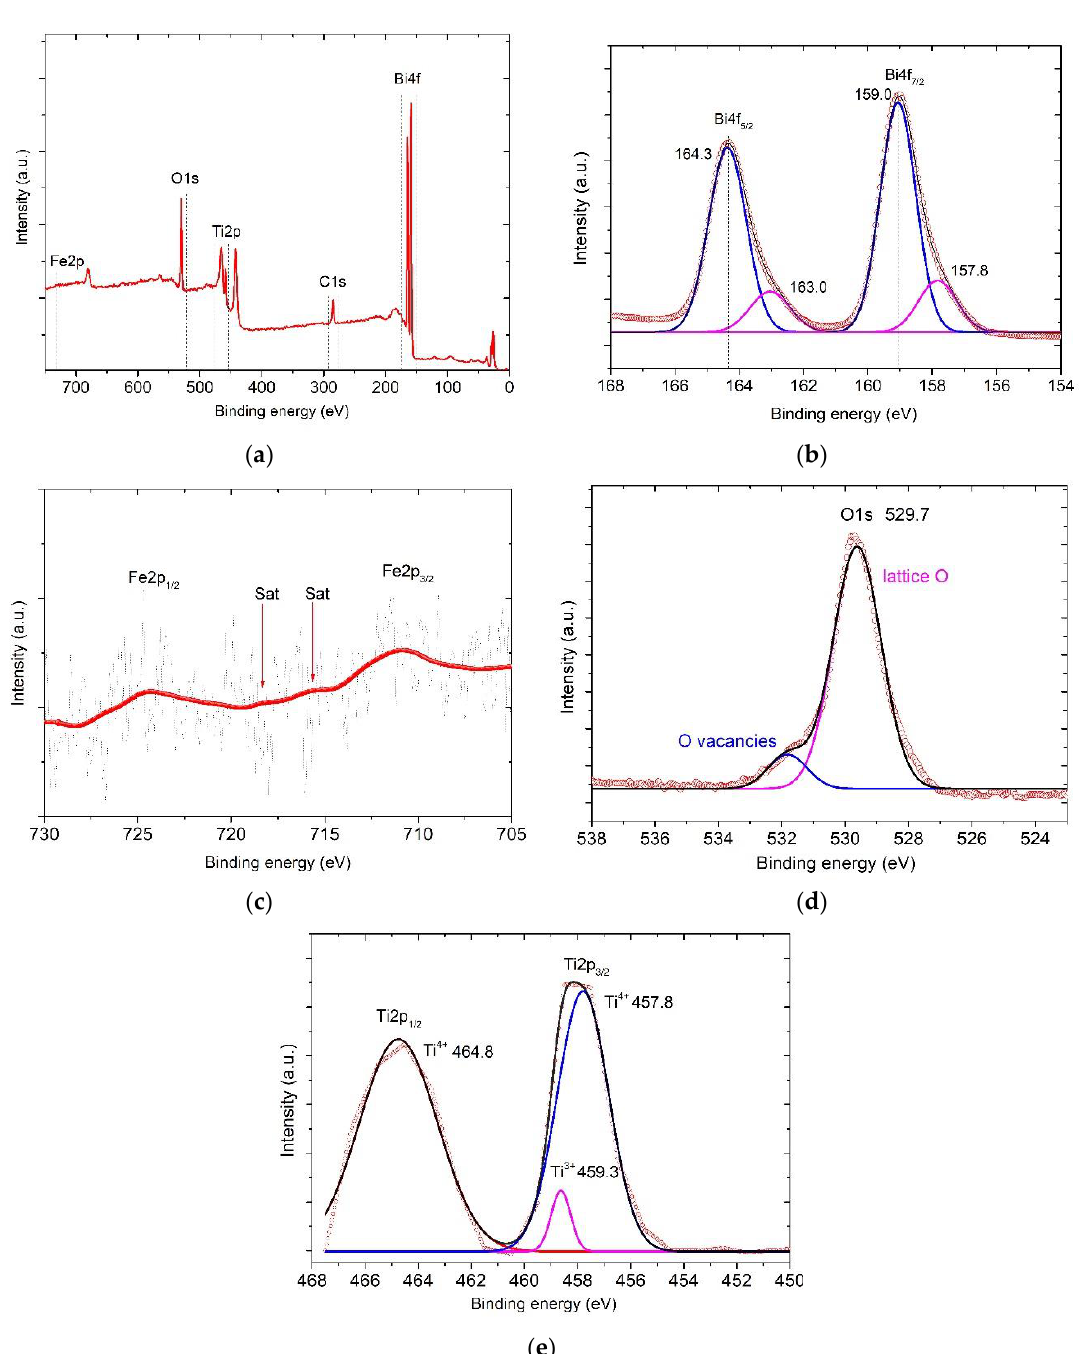
Figure 6. ( a ) Survey X-ray photoelectron spectrometer (XPS) spectra for the ALD-coated TiO 2 NT. ( b ) High-resolution Bi 4f spectra; ( c ) high-resolution Fe 2p spectra; ( d ) high-resolution O 1s spectra; ( e ) high-resolution Ti 2p spectra.